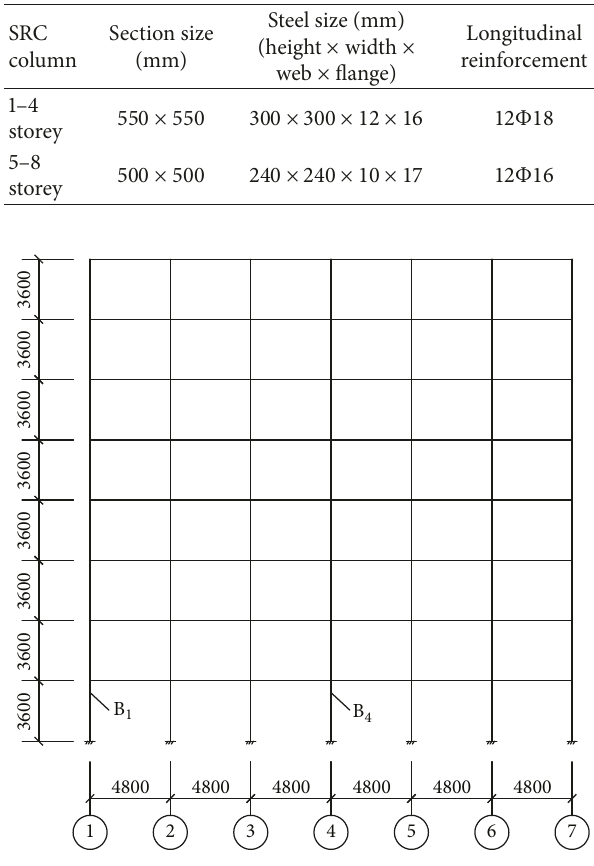
Table 1: Cross section of SRC column.